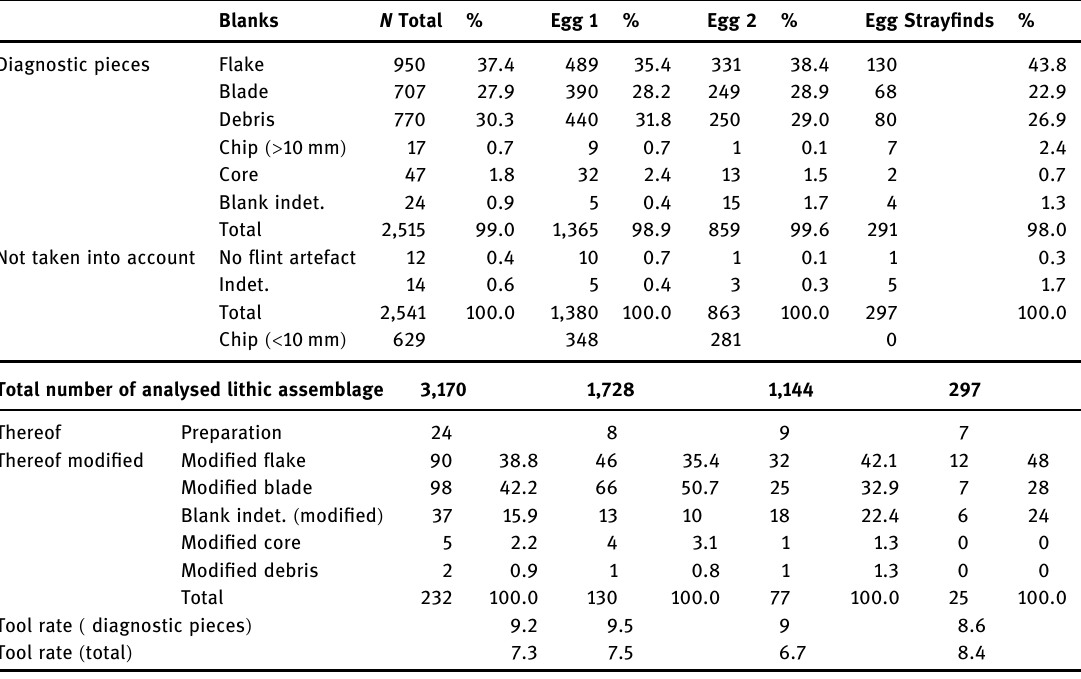
Table 1: Lithic assemblage Egg - Schwarzwasser